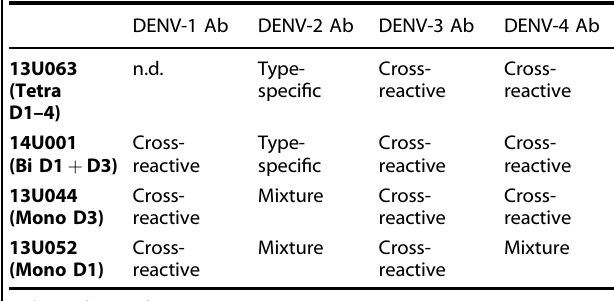
Fig. 8 Type-speci fi c neutralizing antibody responses of representative animals in each PIV primed/LAV boosted group. Sera were depleted of antibody by sequential rounds of incubation with polystyrene magnetic particles coated with BSA (control depleted), DENV-2 virions (D2 depleted), or DENV-1, -3, and -4 virions (D1 + D3 + D4 depleted). Neutralizing activity of depleted sera was tested by FlowNT. Data are presented as log 10 -transformed NT50 values against each DENV type. Table 3. Predominant neutralizing antibody speci fi city against each DENV type for a representative animal in each PIV primed/LAV boosted group.